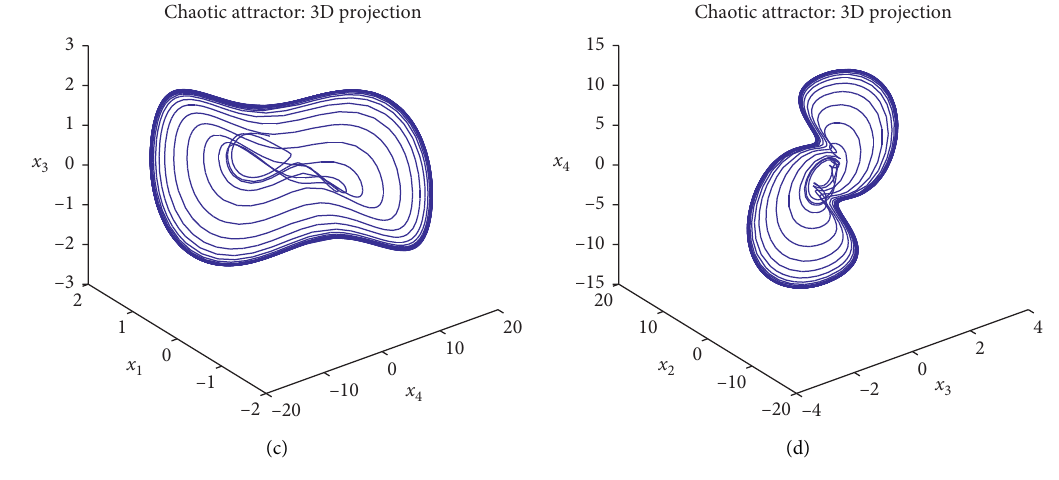
Figure 8: Chaotic attractors.